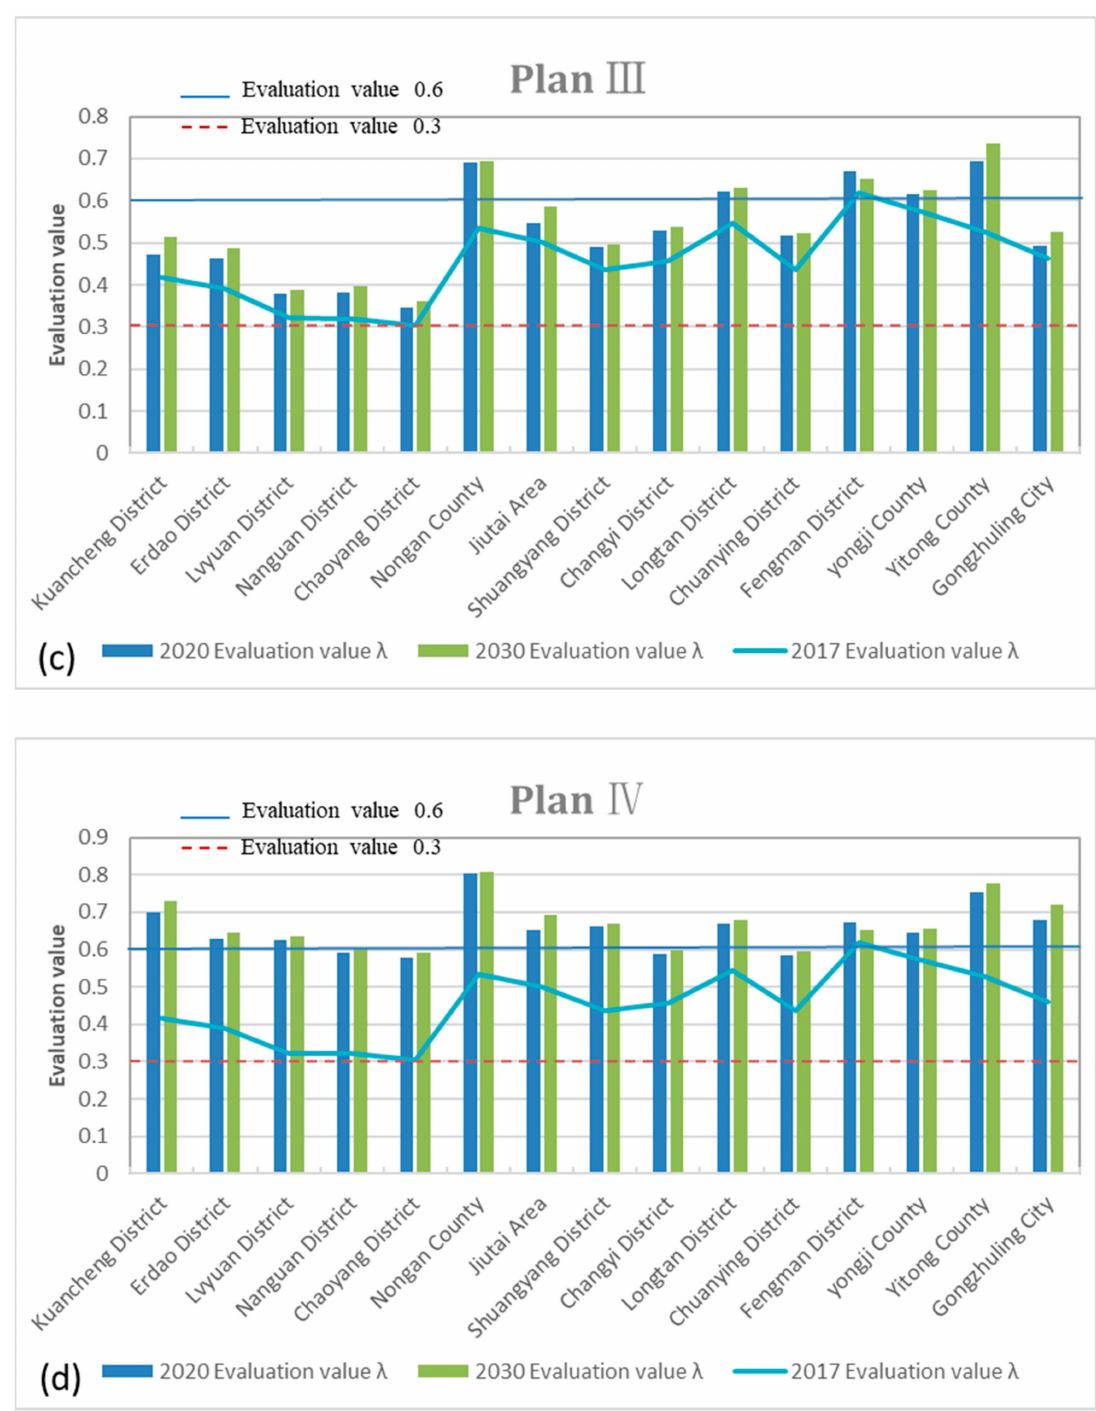
Figure 3. WRCC evaluation value of each region in different Plan. ( a ) Plan I ( b ) Plan II ( c ) Plan III ( d ) Plan